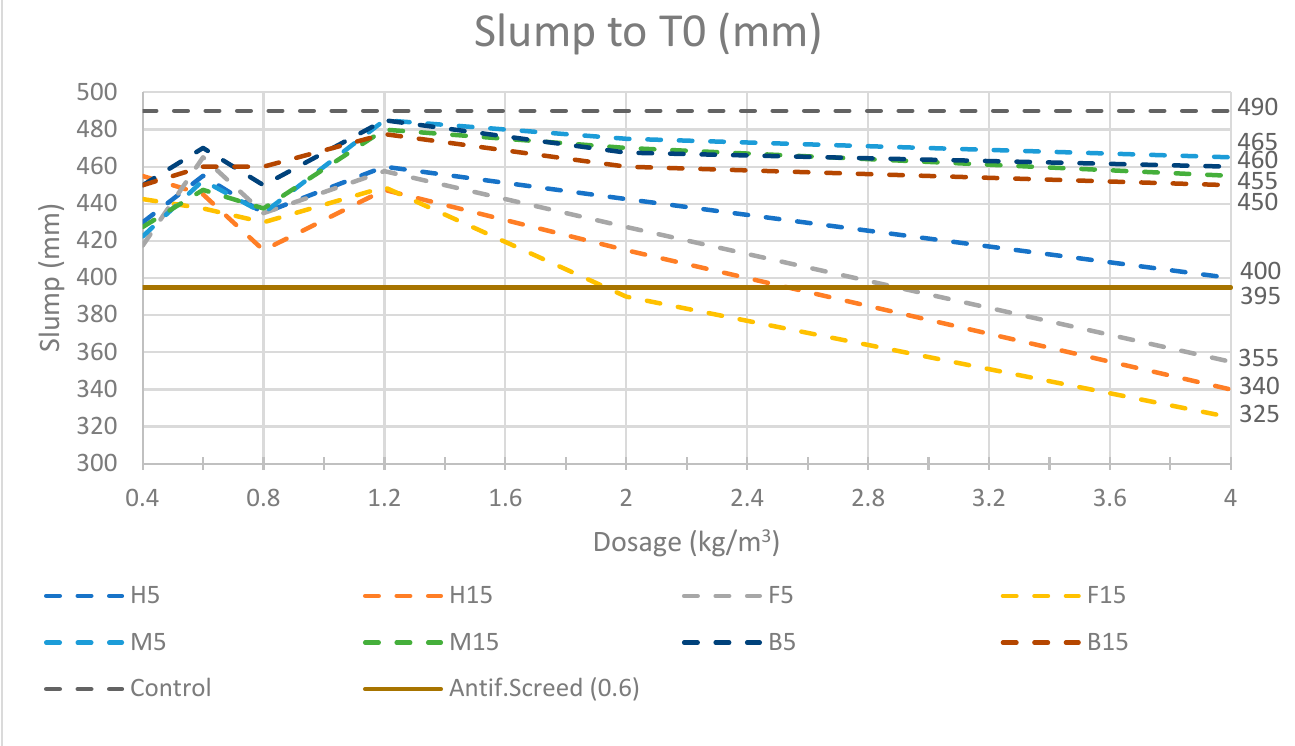
Figure 7. Graphique of slump at 0 min for soft and rigid fibers for all fiber dosages.